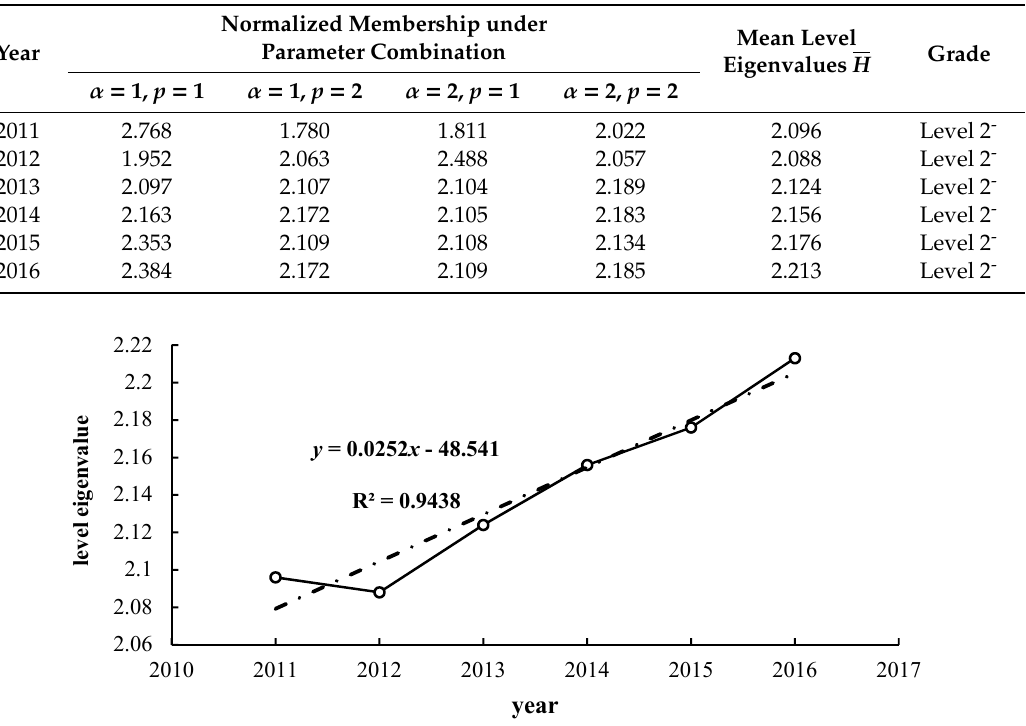
Table 11. Level characteristic values of comprehensive evaluation of consequences in 2011-2016.